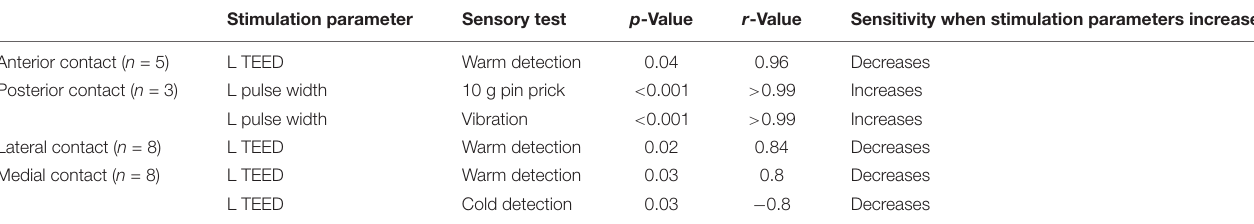
TABLE 4 | Correlation between stimulation parameters and outcome measures.